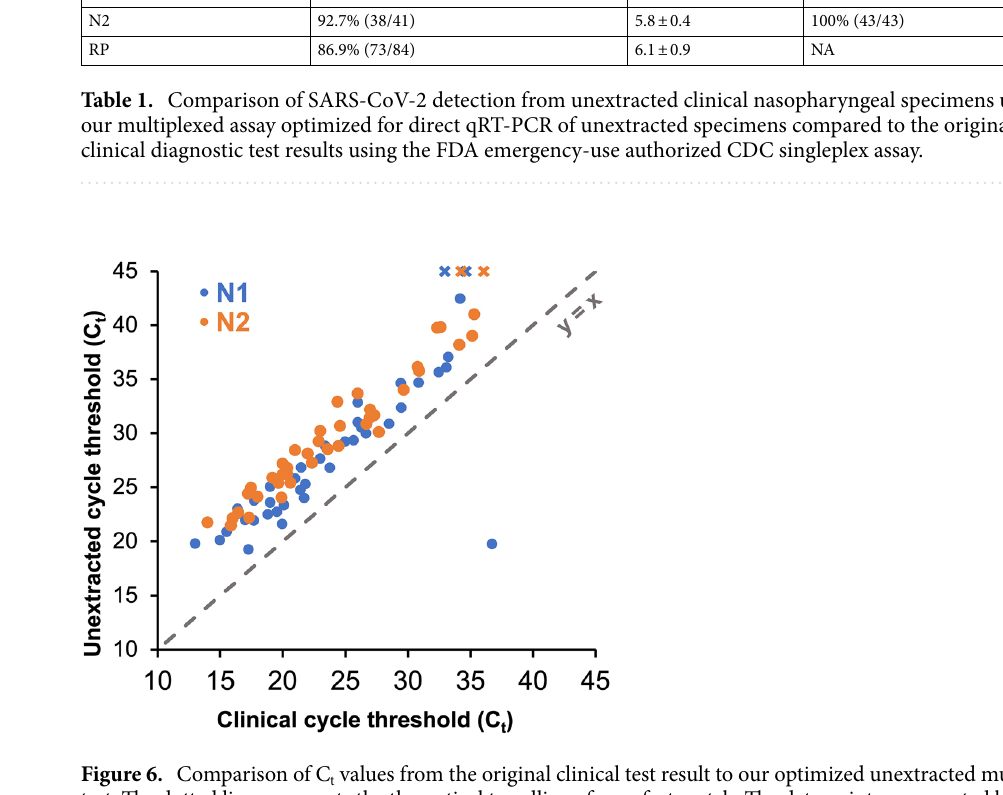
Figure 6. Comparison of C t values from the original clinical test result to our optimized unextracted multiplex test. The dotted line represents the theoretical trendline of a perfect match. The data points represented by the “x” symbols were not detected (i.e., did not amplify within 45